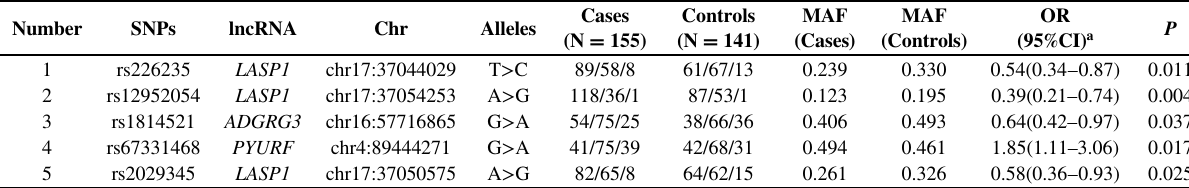
Table 2 Characteristics of the fi ve SNPs in this